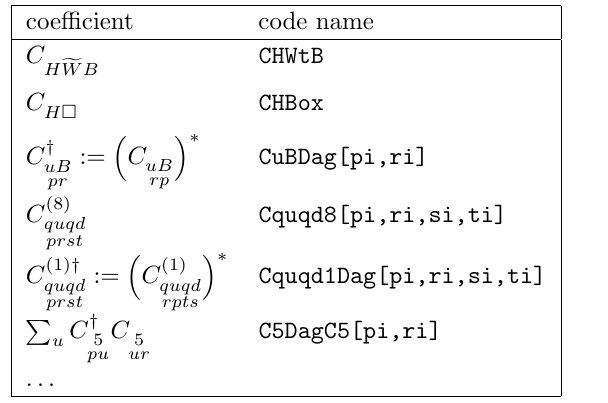
Table 7 . Examples of SMEFT Wilson coe(cid:14)cients appearing in the code with the one-loop matching results, provided as supplemental